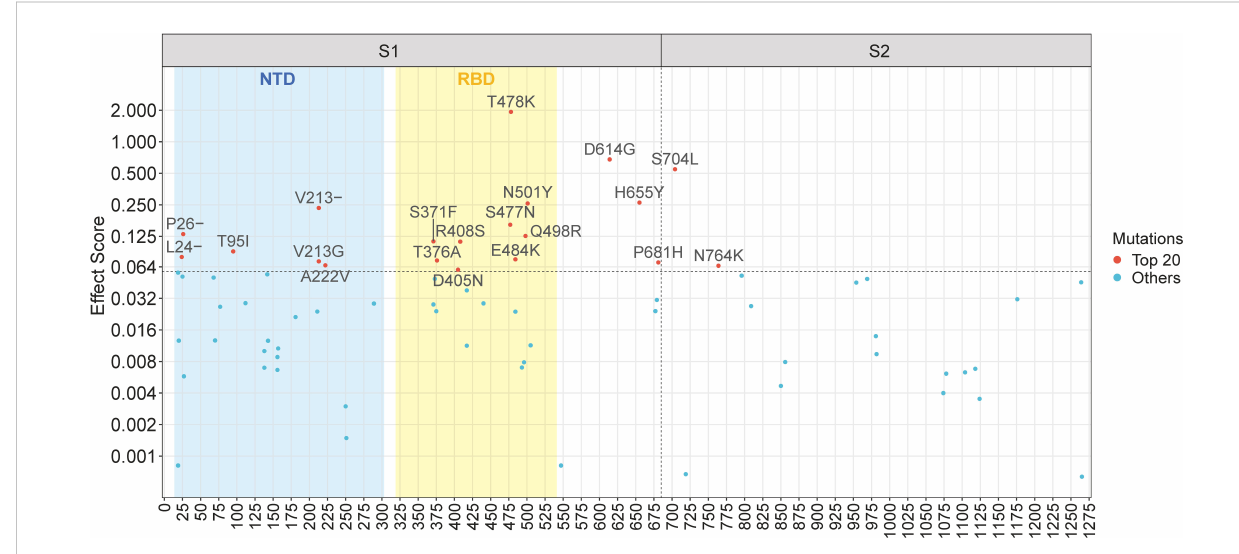
FIGURE 3 Manhattan plot of mutations with positive effect scores across the Spike gene. The top twenty mutations are explicitly labelled. The vertical dashed line represents the S1-S2 subunit boundary (amino acid position 685). The horizontal dashed line represents the lower limit of the top twenty mutations. The blue and yellow rectangles represent the region of the N-terminal domain (NTD) and the receptor-binding domain (RBD),